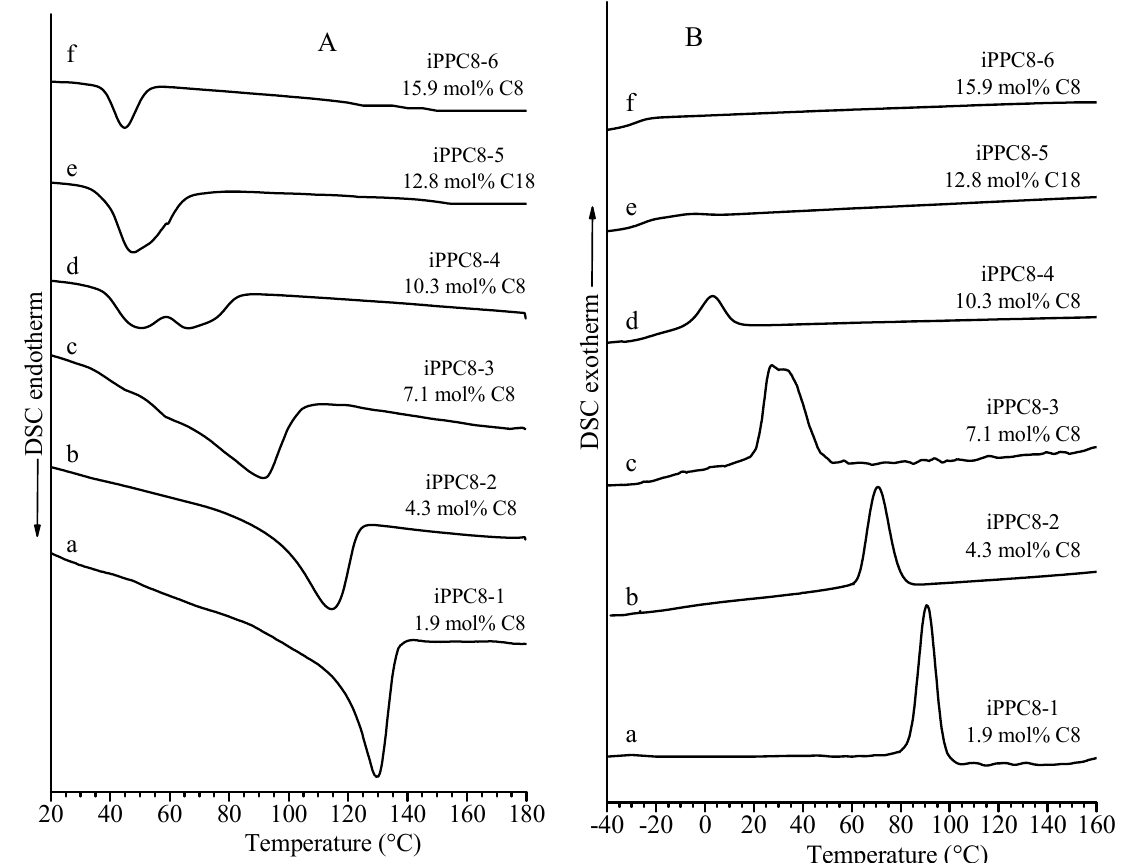
Figure 2. DSC heating ( A ) and cooling ( B ) curves of as-prepared samples of iPPC8 copolymers of the indicated 1‒octene concentration ( a – f ).